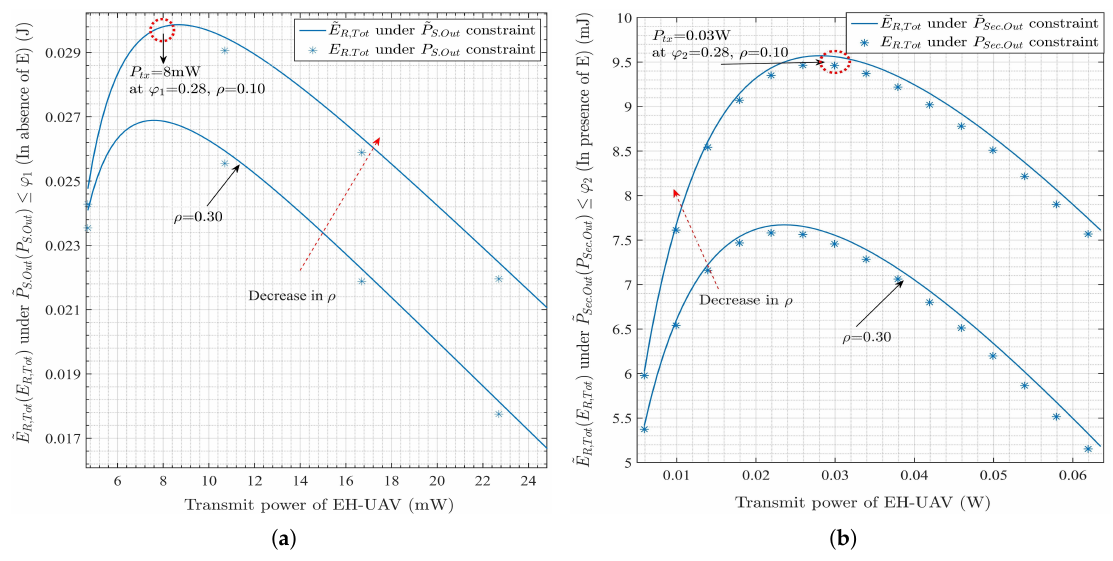
Figure 6. Exact and approximated total residual energy as a function of P tx for EH-UAV under ( a ) connection outage constraint, ( b ) secrecy outage constraint.